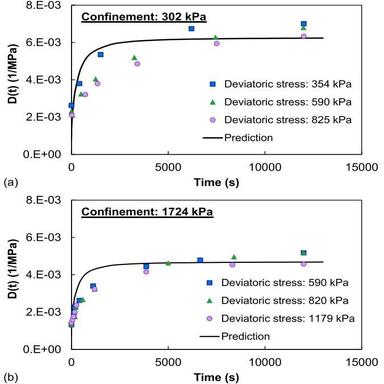
Measured and predicted creep compliances at different confining levels.